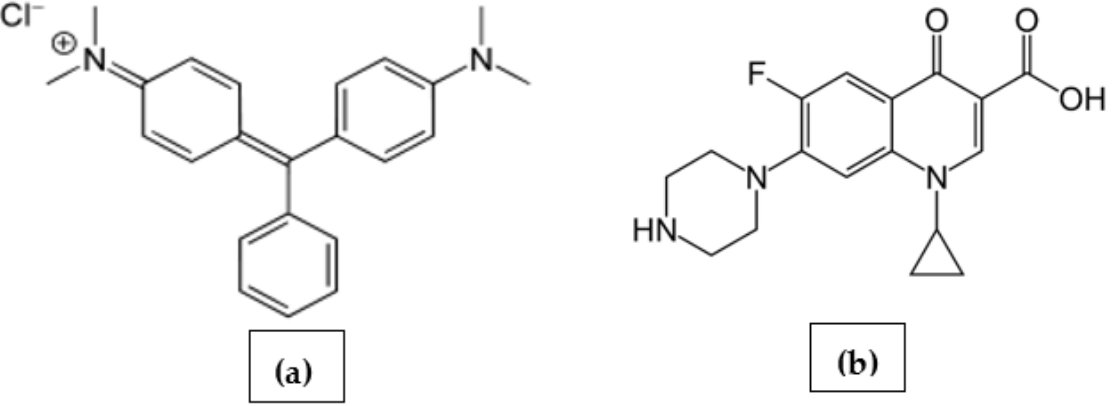
Figure 1. The chemical formulae of ( a ) malachite green dye and ( b ) ciprofloxacin antibiotic.